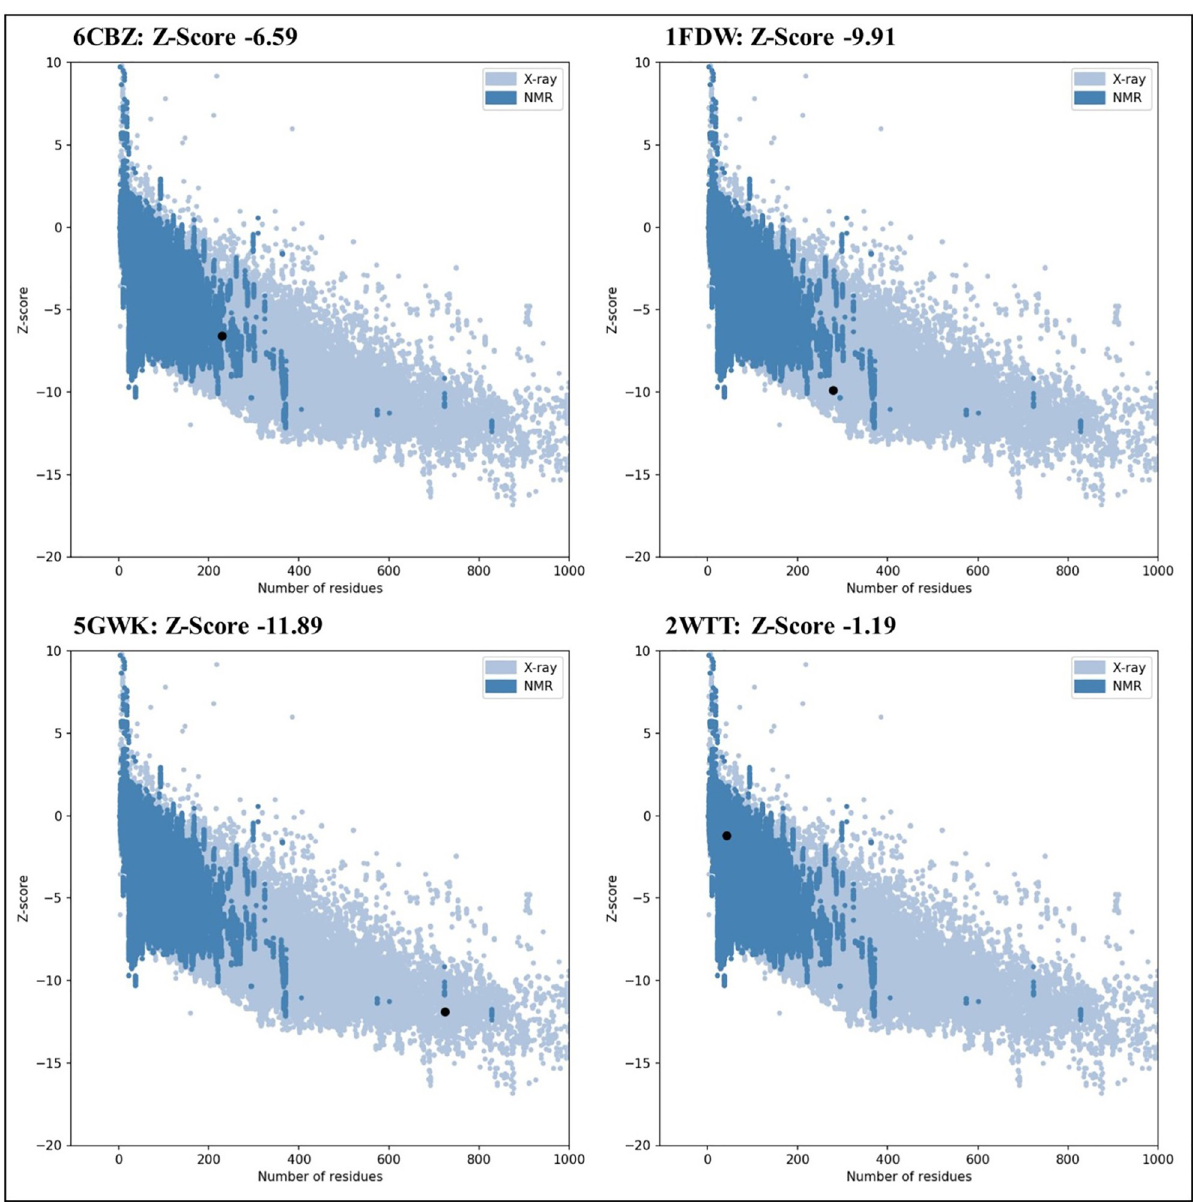
Fig 3. Z-score for the model of the structure of multiple proteins generated by ProSA web